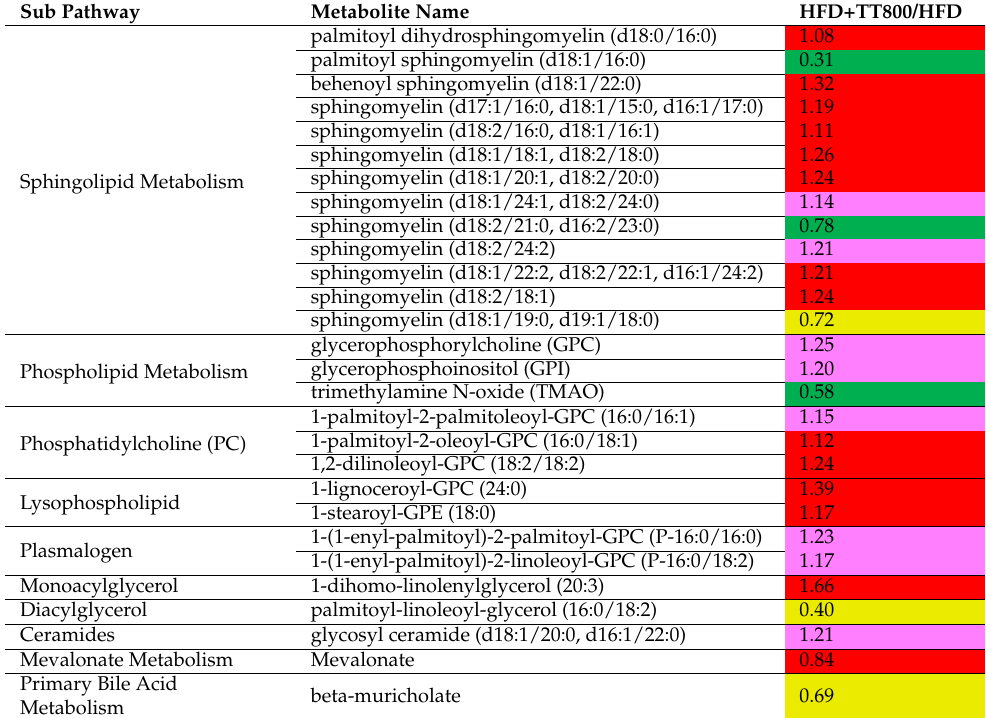
Table 3. Effects of TT supplementation on serum sphingolipid, phospholipid, and other lipid metabolites in mice fed HFD compared to the HFD control